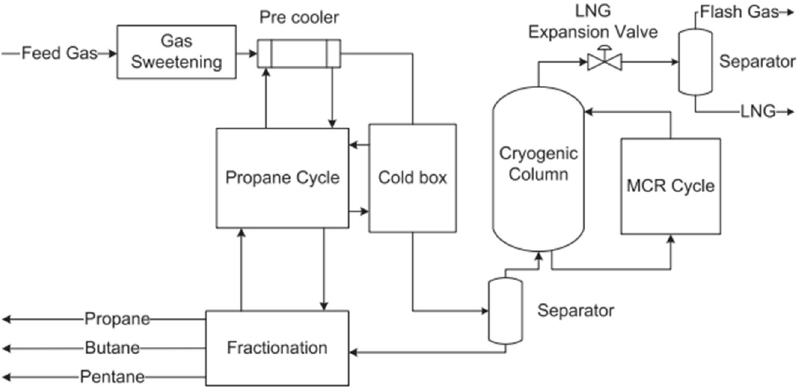
Reproduced with permission from Elsevier (license number 5413480463759). Figure 36. C3MR natural gas liquefaction process [130].